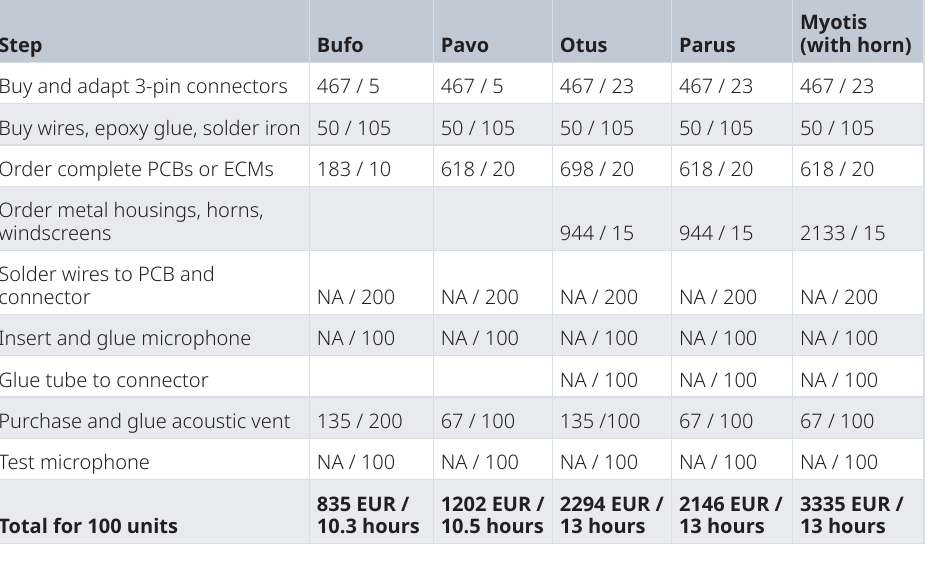
Table 1. Cost (EUR) and labor (min) for each step of building the five recommended designs. Prices (as of December 2018) do not increase proportionally with the number of units due to economies of scale. Complete data are available from the Open Science Framework 14 .